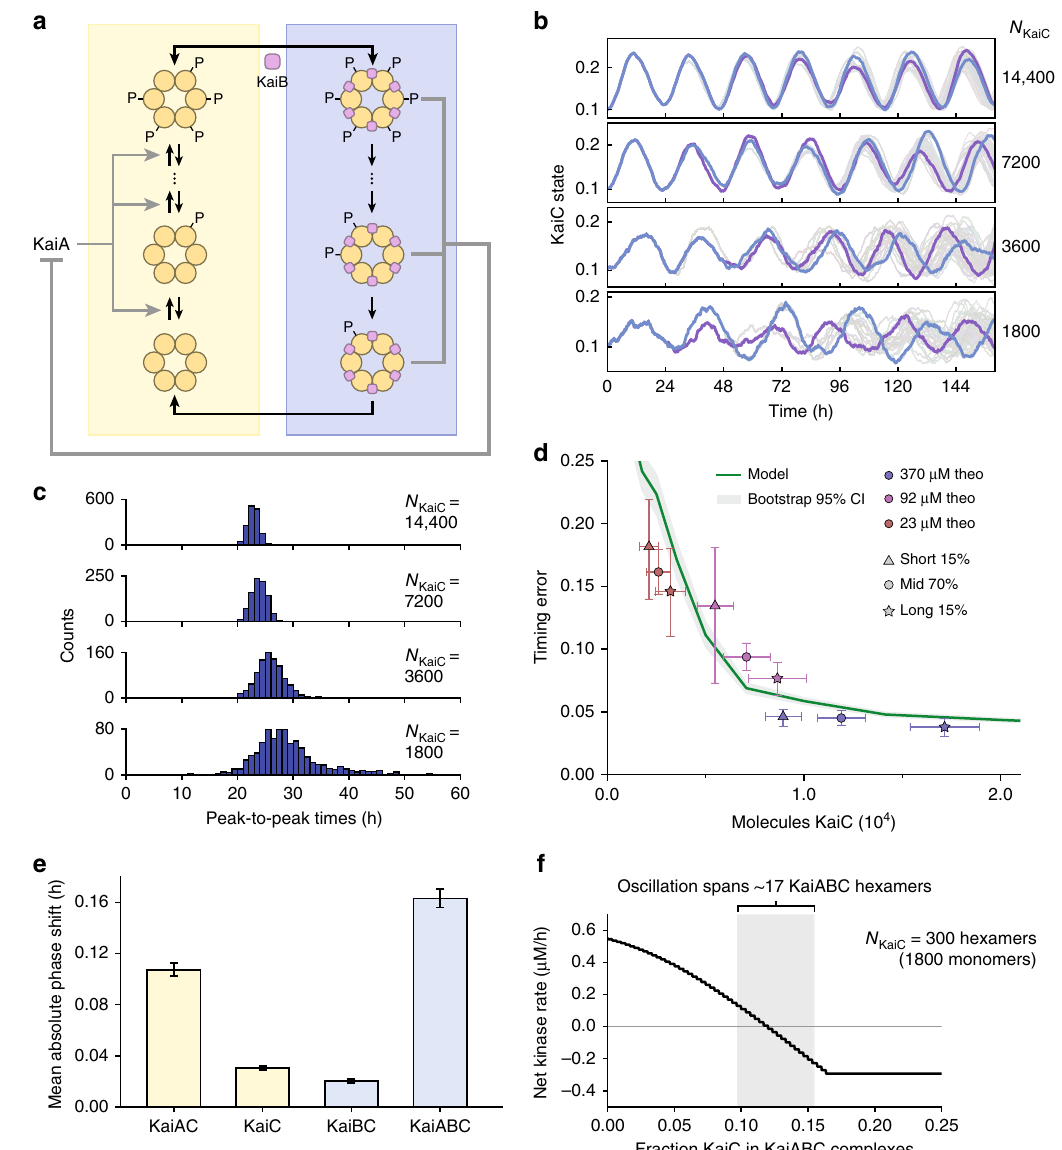
Fig. 3 KaiA-dependent negative feedback loop is the noise bottleneck in a stochastic model of the Kai system. a Model of post-translational oscillator. KaiC hexamers undergo ordered phosphorylation (yellow box) and dephosphorylation (blue box). KaiA is required for KaiC phosphorylation, and dephosphorylating KaiC binds to KaiB to sequester and inhibit KaiA. (see Supplementary Fig. S5). b Simulated stochastic single cell trajectories (gray) at various Kai copy numbers with two example traces highlighted (blue and purple). “ KaiC state ” indicates the average position of KaiC molecules in the oscillator loop. c Distributions of peak-to-peak time intervals in the stochastic model. d Comparison of model and experimental data. Vertical error bars indicate 95% con fi dence interval from bootstrapping (5000 iterations). Horizontal error bars indicate standard error of the mean ( n = 3). Gray interval indicates the 95% bootstrapping con fi dence interval for the model. e Mean phase shift caused by Poisson noise perturbations to molecular species in the model ( n = 500 trials). Error bars indicate 95% con fi dence interval from bootstrapping. f Instantaneous KaiC phosphorylation rate vs. fraction of KaiC in KaiABC complexes in the stochastic model for N KaiC = 300 hexamers. Shaded area indicates the range over which KaiABC complexes